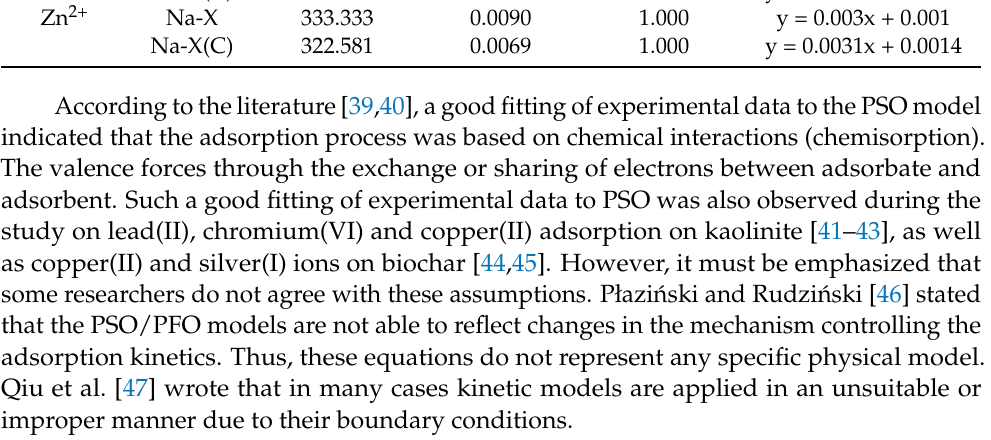
Table 4. Isotherm parameters of Pb 2+ and Zn 2+ adsorption on the Na-X and Na-X(C) surfaces at pH 5.